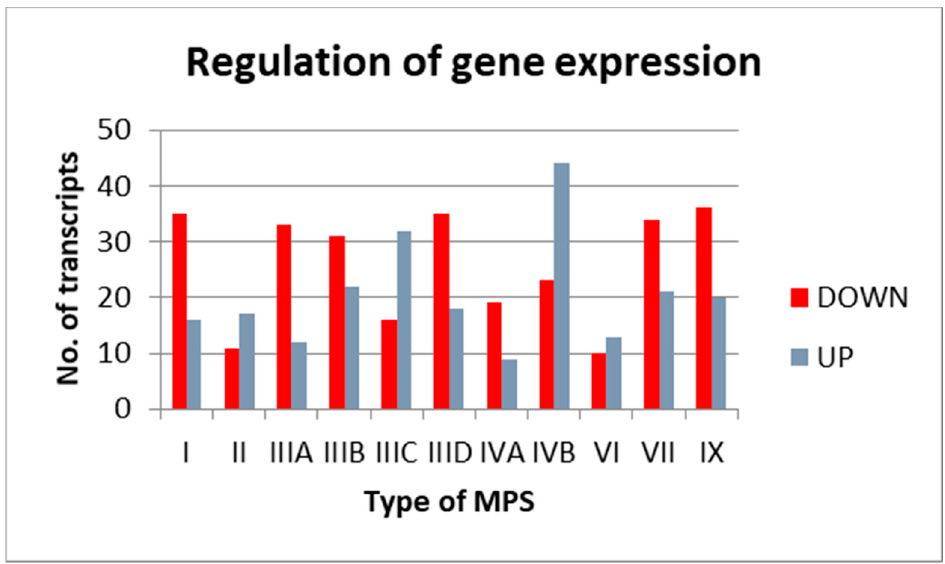
Figure 2. Number of transcripts coding for proteins involved in the regulation of gene expression (GO:0010468) with changed levels (at FDR < 0.1; p < 0.1) in different types of MPS relative to control cells (HDFa). Down- and up-regulated transcripts are marked (DOWN and UP, respectively).